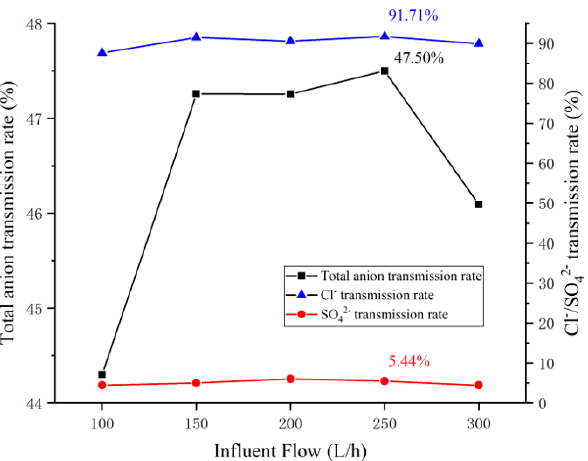
Figure 3. Influence of influent flow rate on the anion transmission rate of the device.